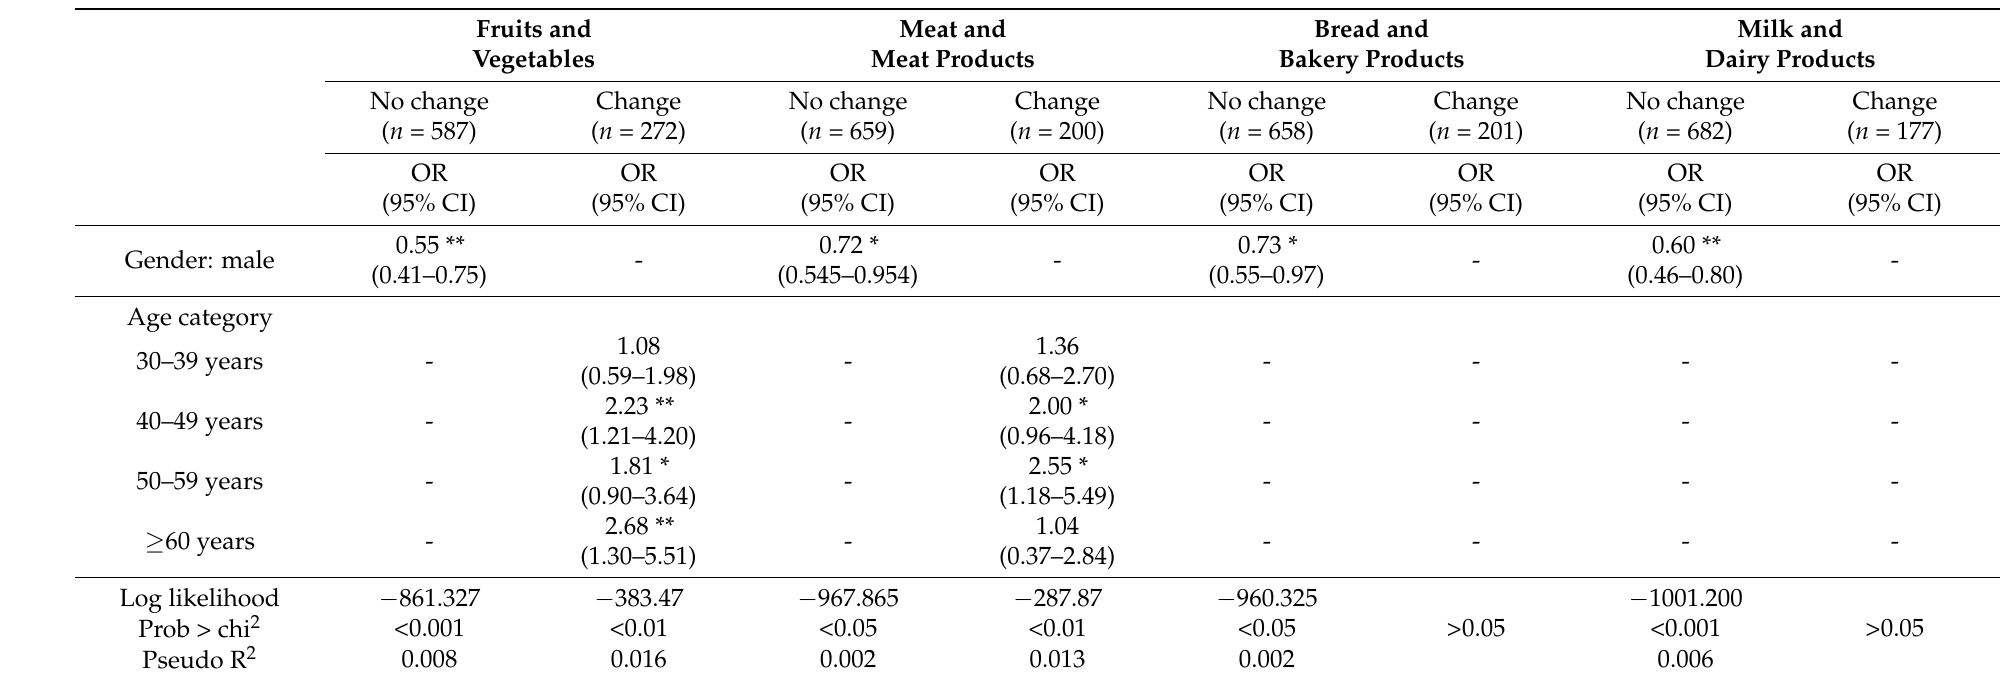
Table 2. Ordered logistic regression results—dependent variable: “I shop at shops near the